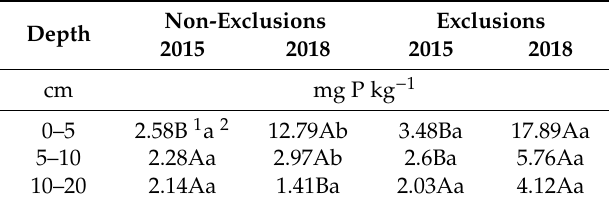
Table 4. Median Mehlich-1 phosphorus (M1P) in exclusions and non-exclusions in 2015 (Baseline) and 2018 (Post-Treatment) in strategic grazing (STR)